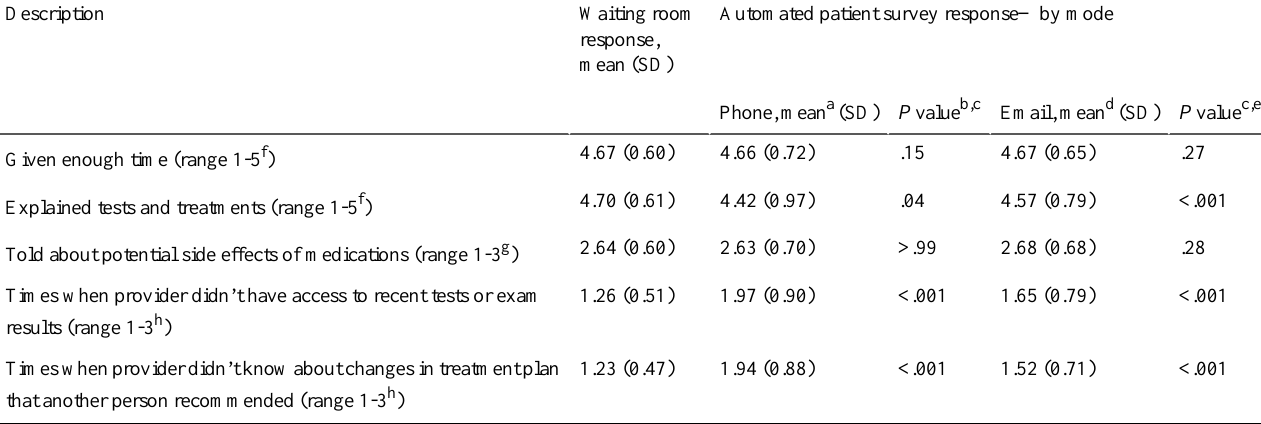
Table 4. Comparison of responses to paper waiting room surveys and automated surveys among those who completed the automated patient survey.